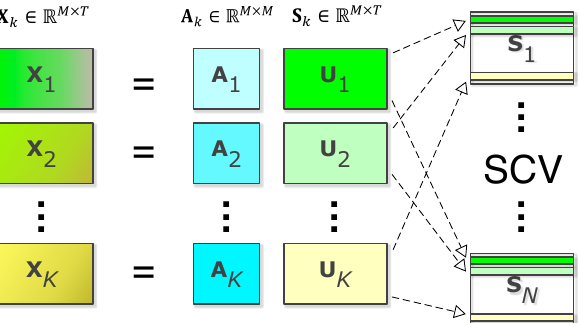
Figure 2. Step 1: IVA step for the fusion of neuroimaging datasets. IVA estimates interpretable components independent within the datasets while maximally correlated with the same index components across the datasets. Subject profiles corresponding to these components represent each subject’s contribution to the components and can be used to identify multivariate associations with behavioral